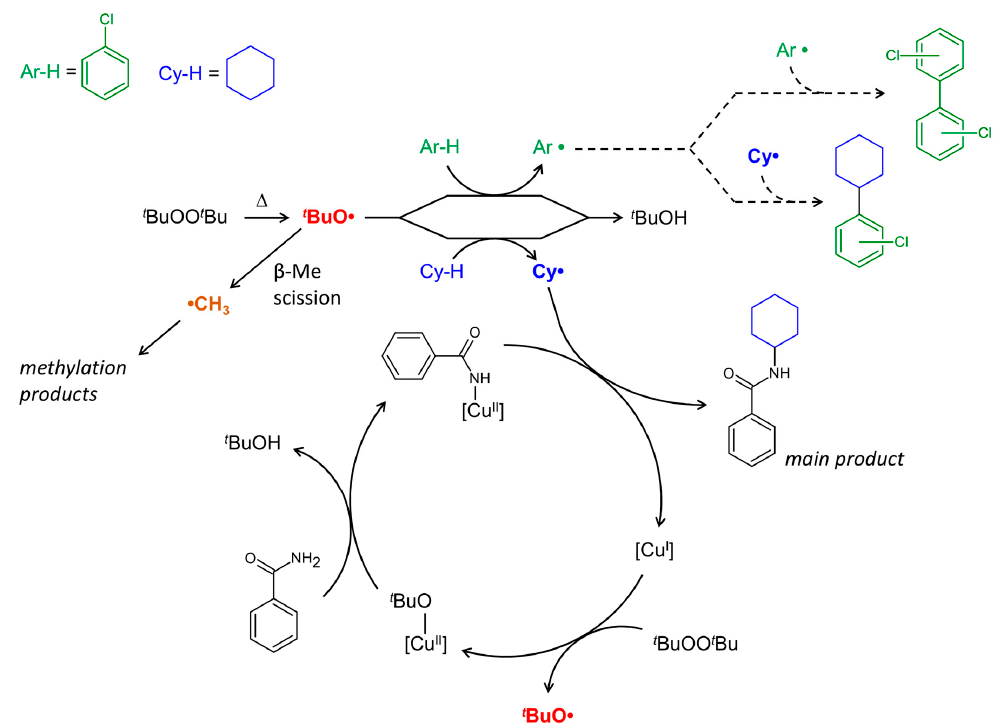
Figure 15. Proposed reaction mechanism for the cyclohexane amidation catalysed by 1 (schematically shown as [Cu]).